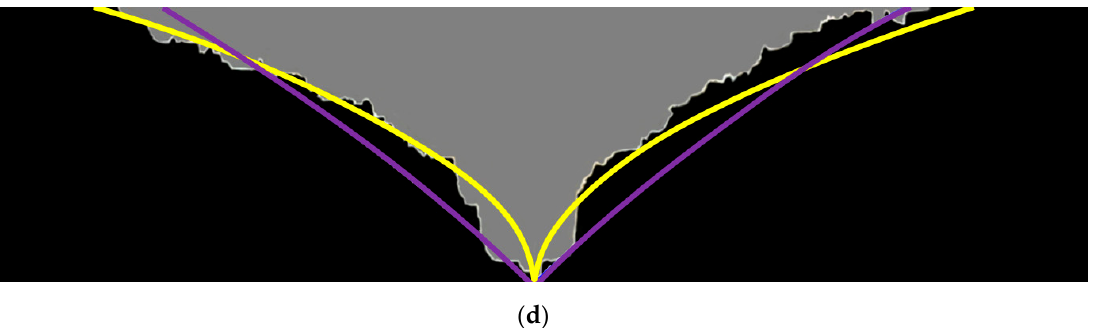
Figure 19. Comparison of the solvent chambers estimated by exponential model, solvent chambers estimated by parabolic model [3], and experimentally visualized [3] solvent chambers in test #4 at ( a ) t = 18 h, ( b ) t = 27 h, ( c ) t = 38 h, and ( d ) t = 52 h.